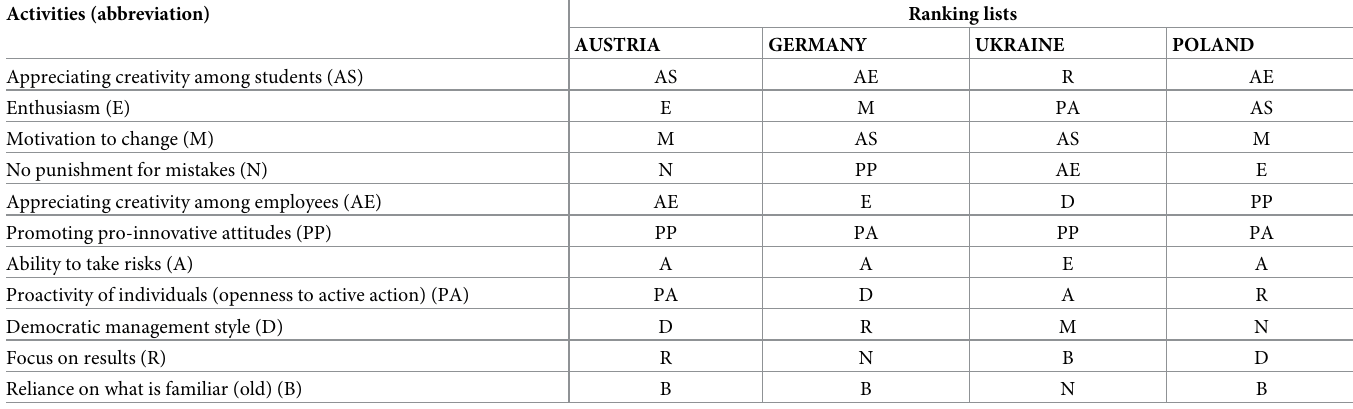
Table 1. Ranking lists of measures to promote innovation-friendly organisational culture at universities.